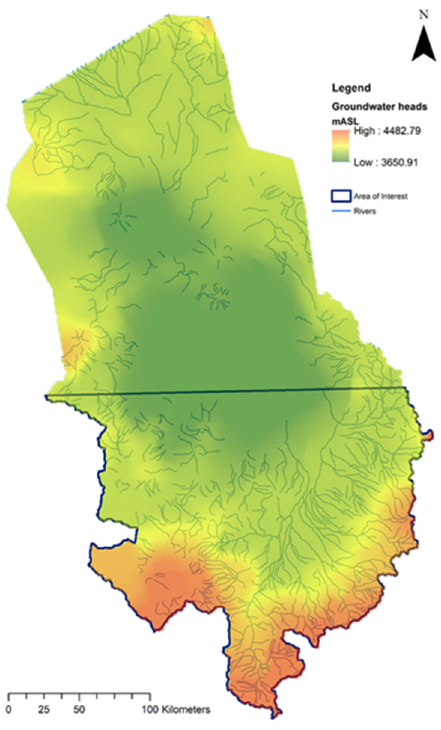
Figure 12. MODFLOW modelling output. Steady-state groundwater heads.